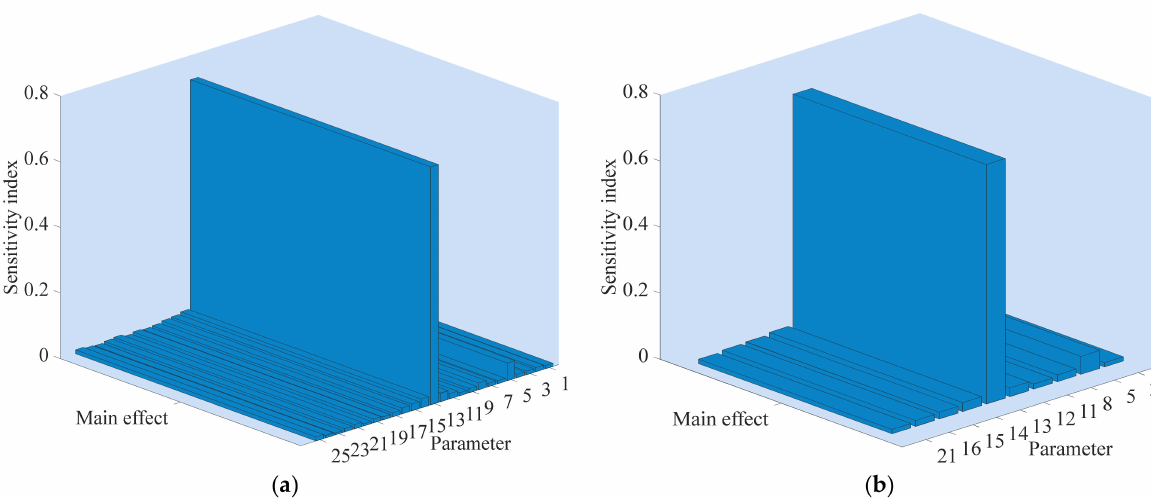
Figure 17. The sensitivity index of parameters of the peak value of the angular velocity. ( a ) The sensitivity index of 25 parameters; ( b ) The sensitivity index of the top 10 parameters. The numbers 1 to 25 represent symbols T , Kp , b p , K d , A t , D t , f p , q nl , T 0 , T d0 , T d00 , T q00 , H , F , K a , R s , L ls , R r , L lr , L m , H 1 , F 1 , WS , Ncellm12 and I r , respectively. For the physical meaning and definitions of these parameters, see Appendix B.